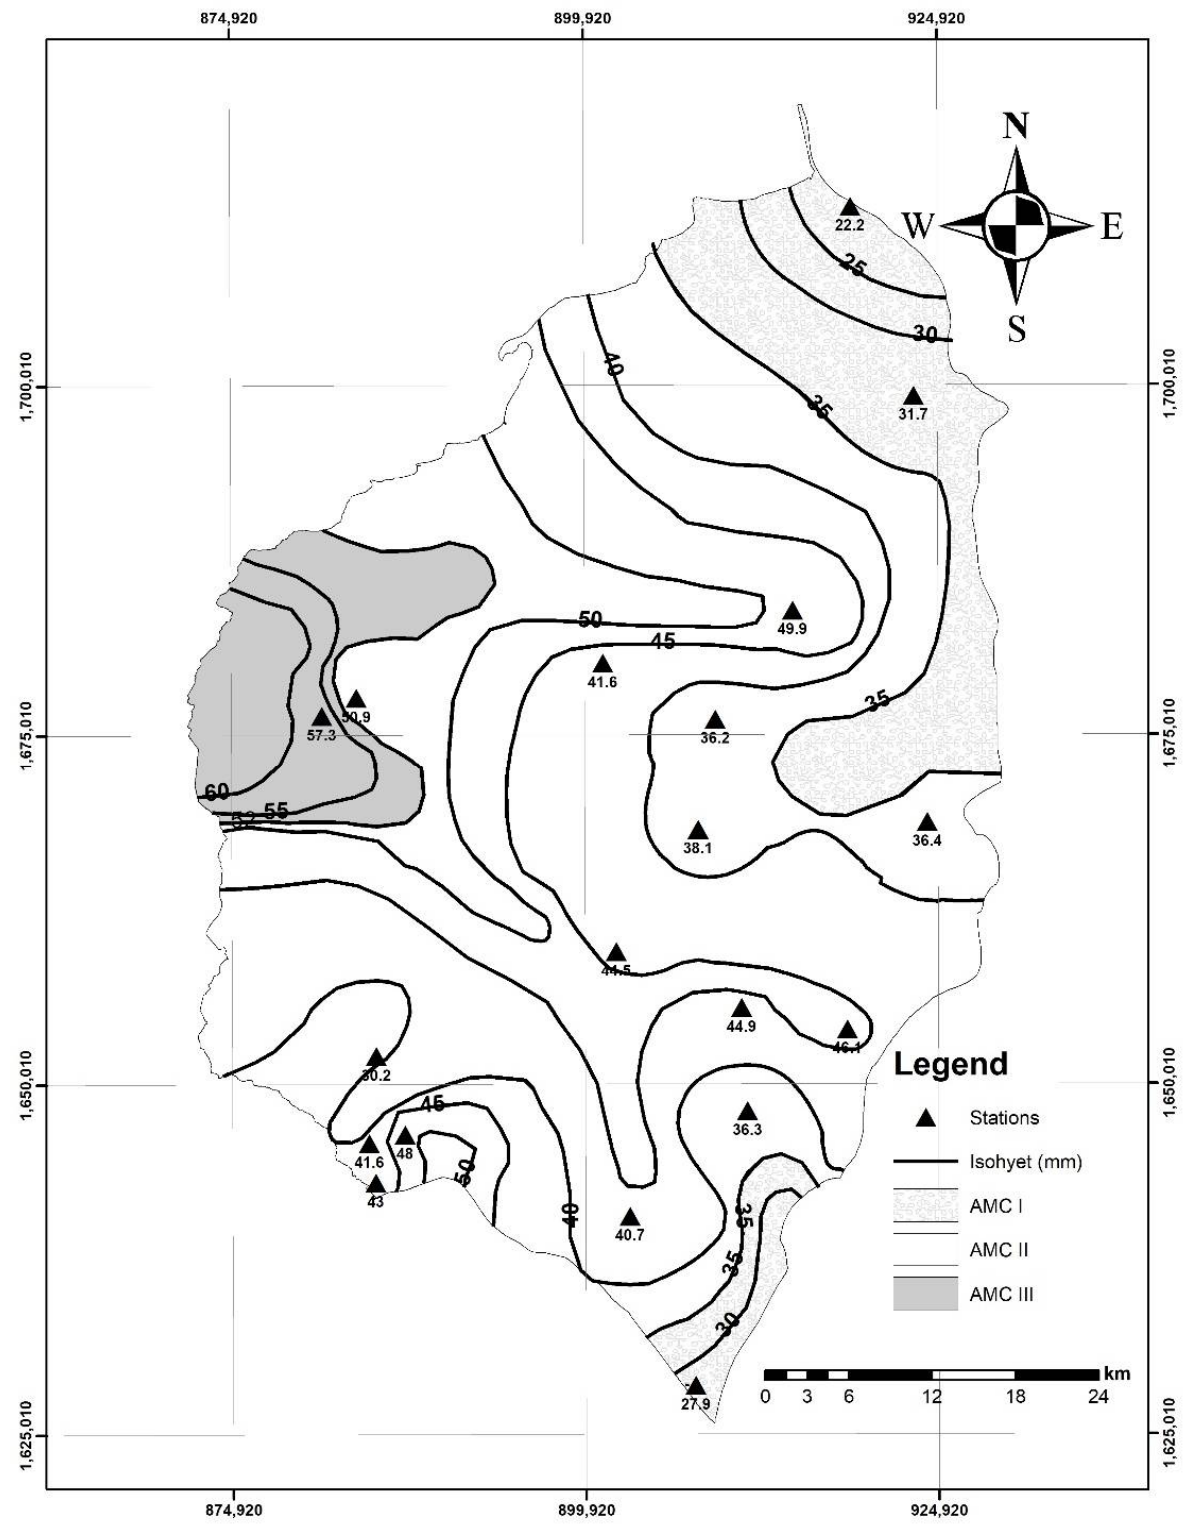
Figure 6. Spatial distribution of P prior-5d of the type of moisture conditions for a return period of 5 years.